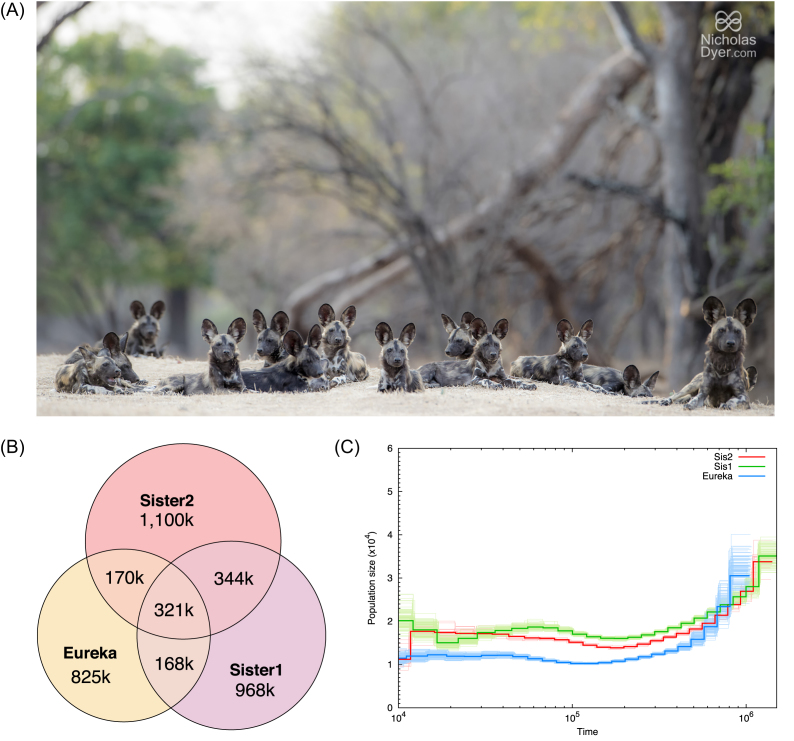

(A) Pack of African wild dogs. (B) Shared heterozygous sites between the three de novo assemblies (calculated using a posterior cutoff of 0.99). More of the heterozygous sites are shared between the two sisters than between either sister and Eureka. (C) Reconstruction of the individuals’ demographic history using the PSMC program. Bootstrap replicates are plotted in lighter colors. Time is in years before present.